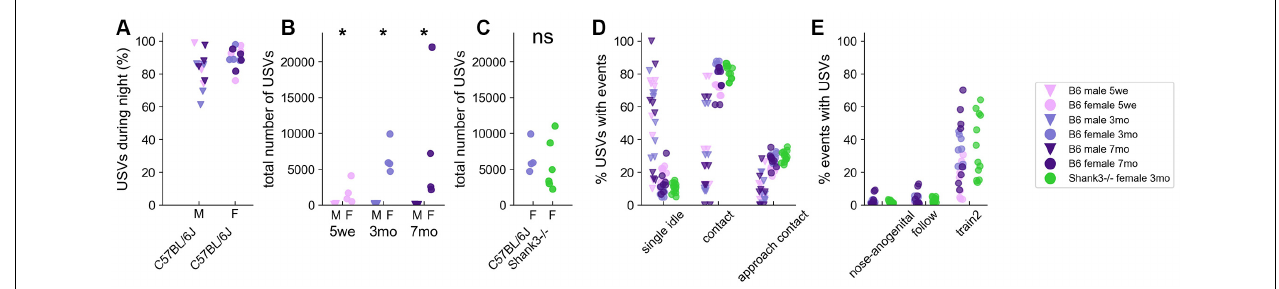
FIGURE 3 | Spontaneous emission of USVs in B6 male and female pairs as well as in Shank3 − / − female pairs over three nights. (A) The proportion of USVs emitted during the night periods of the 3 days of recording in B6 pairs. (B) Total number of USVs recorded in male-male and female-female B6 pairs at 5 weeks, 3 months, and 7 months of age over the 71 h of recording (Mann–Whitney U -tests; uncorrected p -values: * p < 0.05; none of the p -values survived a correction for multiple testing. (C) Total number of USVs recorded in female-female B6 pairs and in female-female Shank3 − / − pairs aged 3 months (Mann–Whitney U -tests; ns: not significant). (D) The proportion of USVs occurring simultaneously with single idle and contact events in male-male and female-female B6 pairs at 5 weeks, 3 months, and 7 months of age (age classes represented by colors) as well as in female-female Shank3 − / − pairs aged 3 months. (E) The proportion of nose-anogenital contacts, follow and train2 behaviors occurring simultaneously with USVs in female-female B6 pairs at 5 weeks, 3 months, and 7 months of age (age classes represented by colors) as well as in female-female Shank3 − / − pairs aged 3